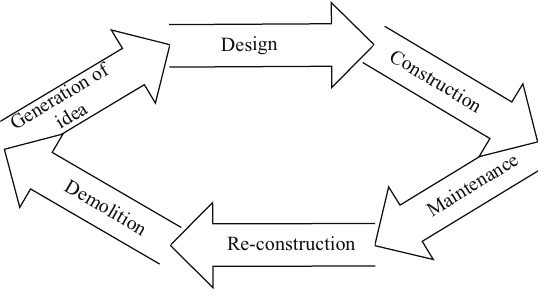
figure 1. lifecycle of a building Simulation based project life cycle